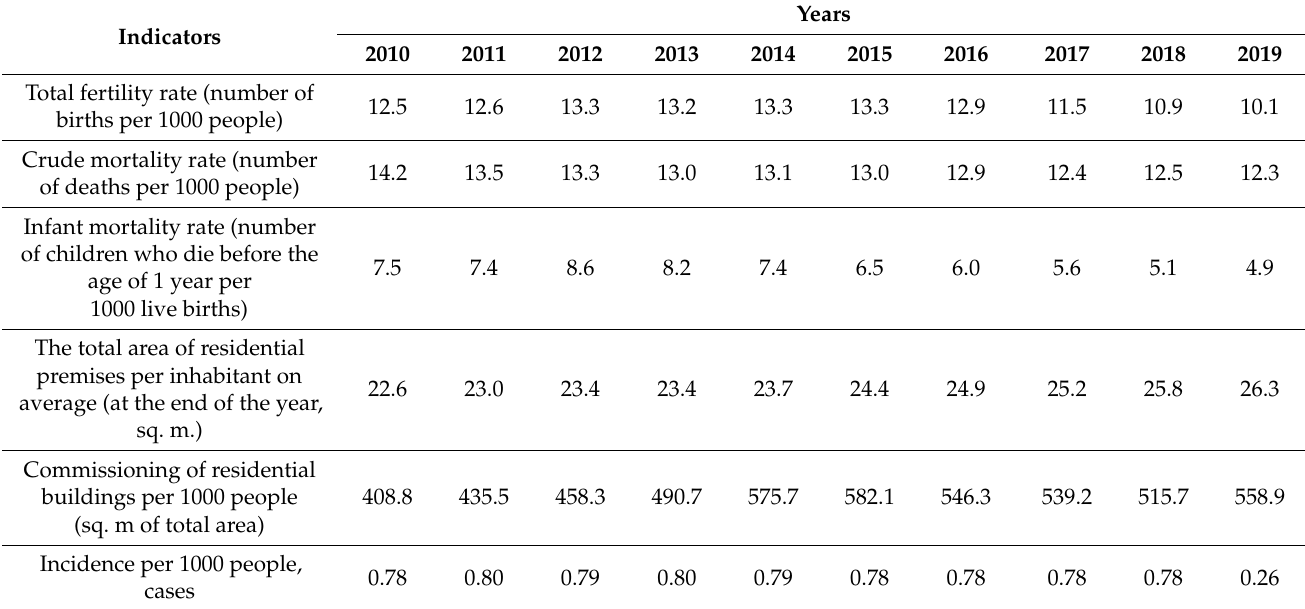
Table 9. Key indicators characterizing the macro-regional block “Society” in the Russian Federation in 2010–2019.